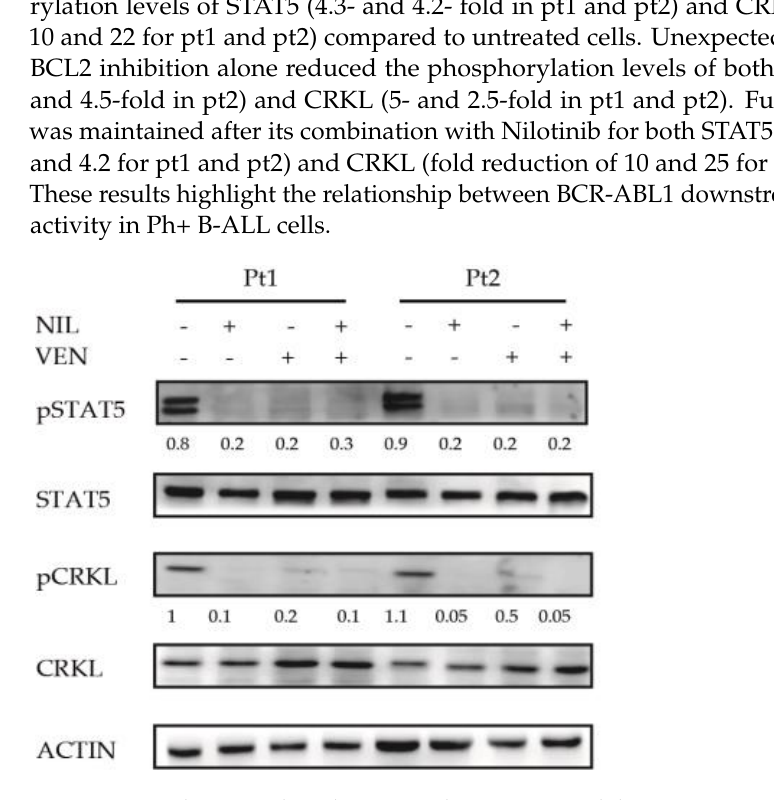
Figure 6. Single or combined BCL2 and BCR-ABL1 inhibition represses the STAT5 and CRKL phosphorylation in Ph+ B-ALL cells. Peripheral blood lymphoblastic cells derived from Ph+ B-ALL patients ( n = 2) were exposed to the indicated drugs (Venetoclax 400 nM, Nilotinib 2 µ M). Cell lysates were separated by SDS-PAGE and nitrocellulose membrane hybridized by specified antibodies. Actin was used as loading control. The numbers indicate the densitometric analysis obtained using Image J software. VEN = Venetoclax, NIL = Nilotinib.